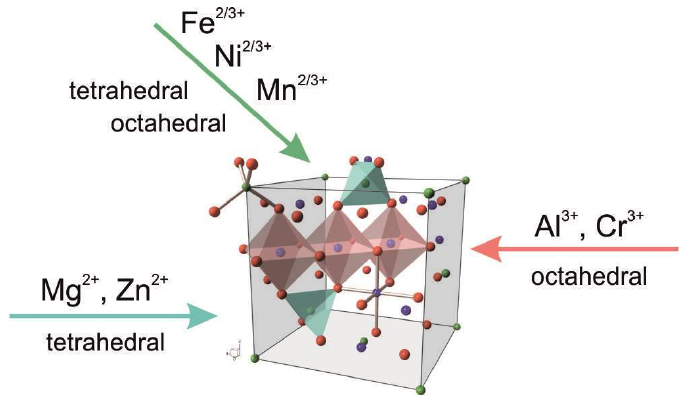
Figure 3. Schematic representation of possible localization sites for bulk promoters in the spinel Figure3. Schematicrepresentationofpossiblelocalizationsitesforbulkpromotersinthespinelstructure. structure.